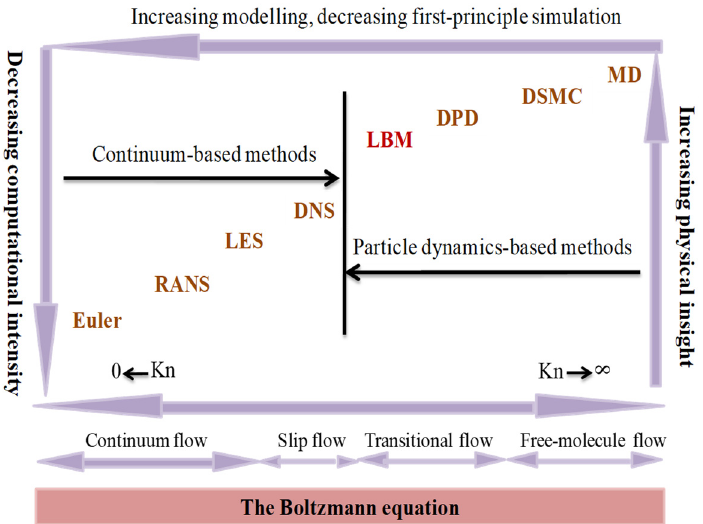
Figure 16. Hierarchy scale of modeling and simulation methods ranging from Euler to molecular dynamics, reprinted/adapted with permission from Ref. [130], 2022, World Scientific.